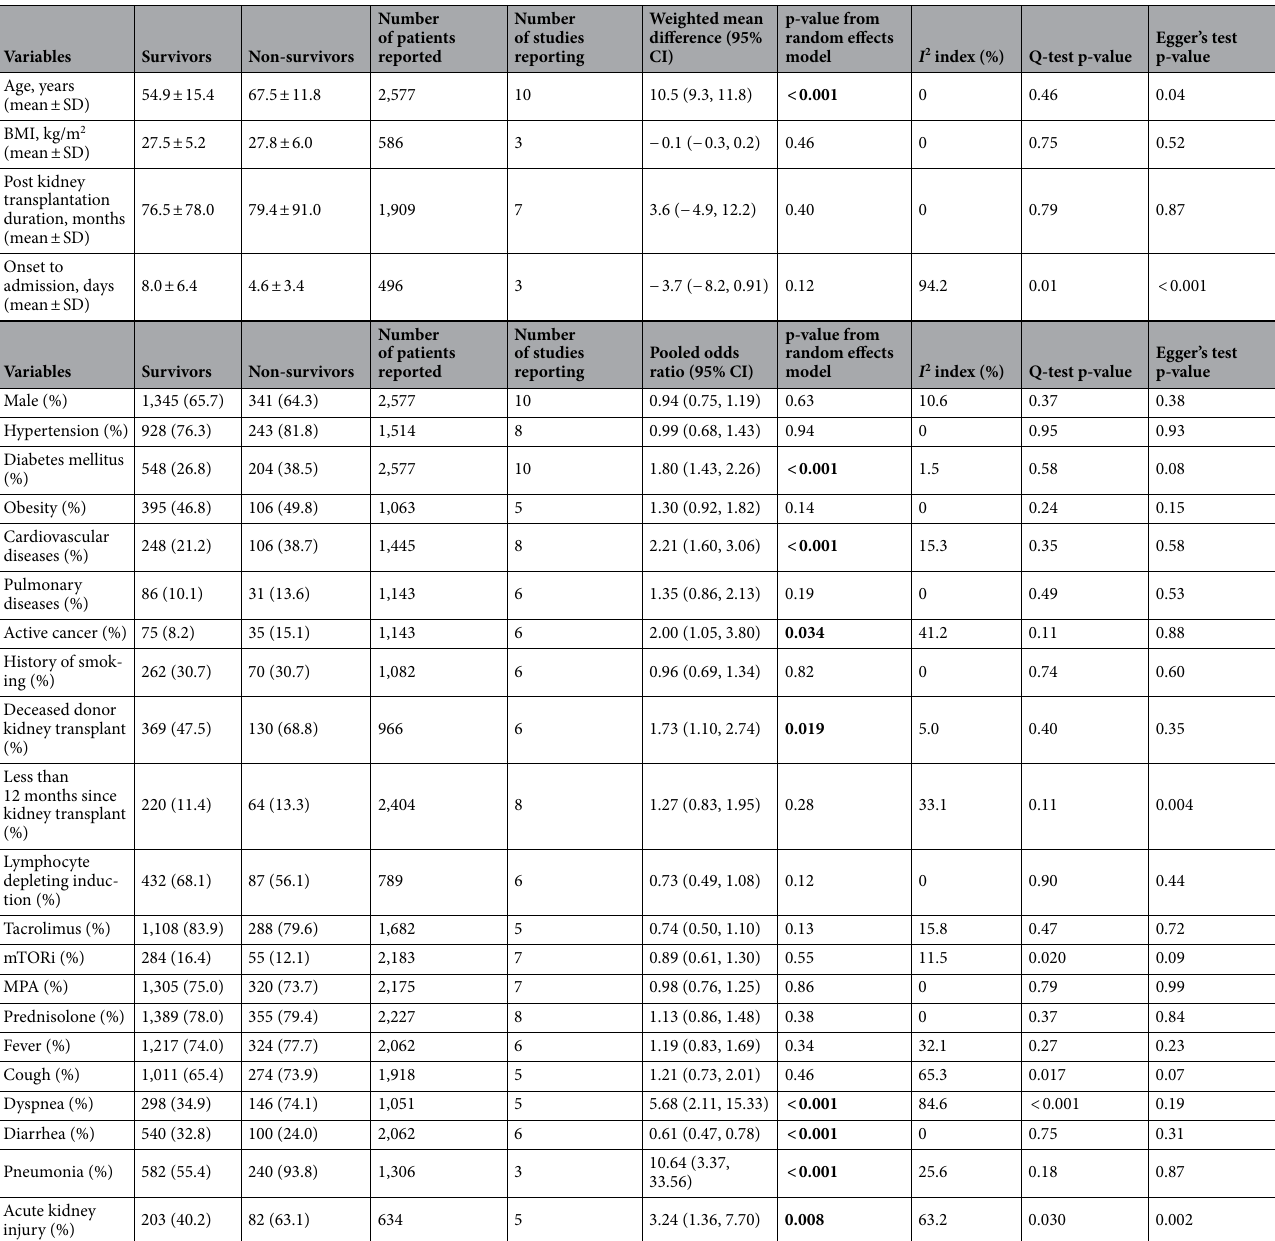
Table 2. Meta-analysis of patient characteristics between survivor and non-survivor kidney transplantation patients. BMI body mass index, CNI calcineurin inhibitor, MPA mycophenolic acid, mTORi mammalian target of rapamycin inhibitor, SpO 2 oxygen